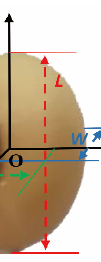
Table 1. No., centre coordinate, and radii of the balls in one soybean particle model. No. Centre Coordinate Radii of the Balls X